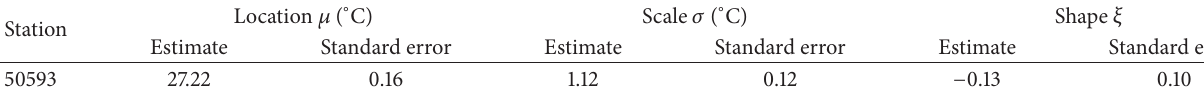
Table 3: Parameter estimates for the GEV distribution by MLE.